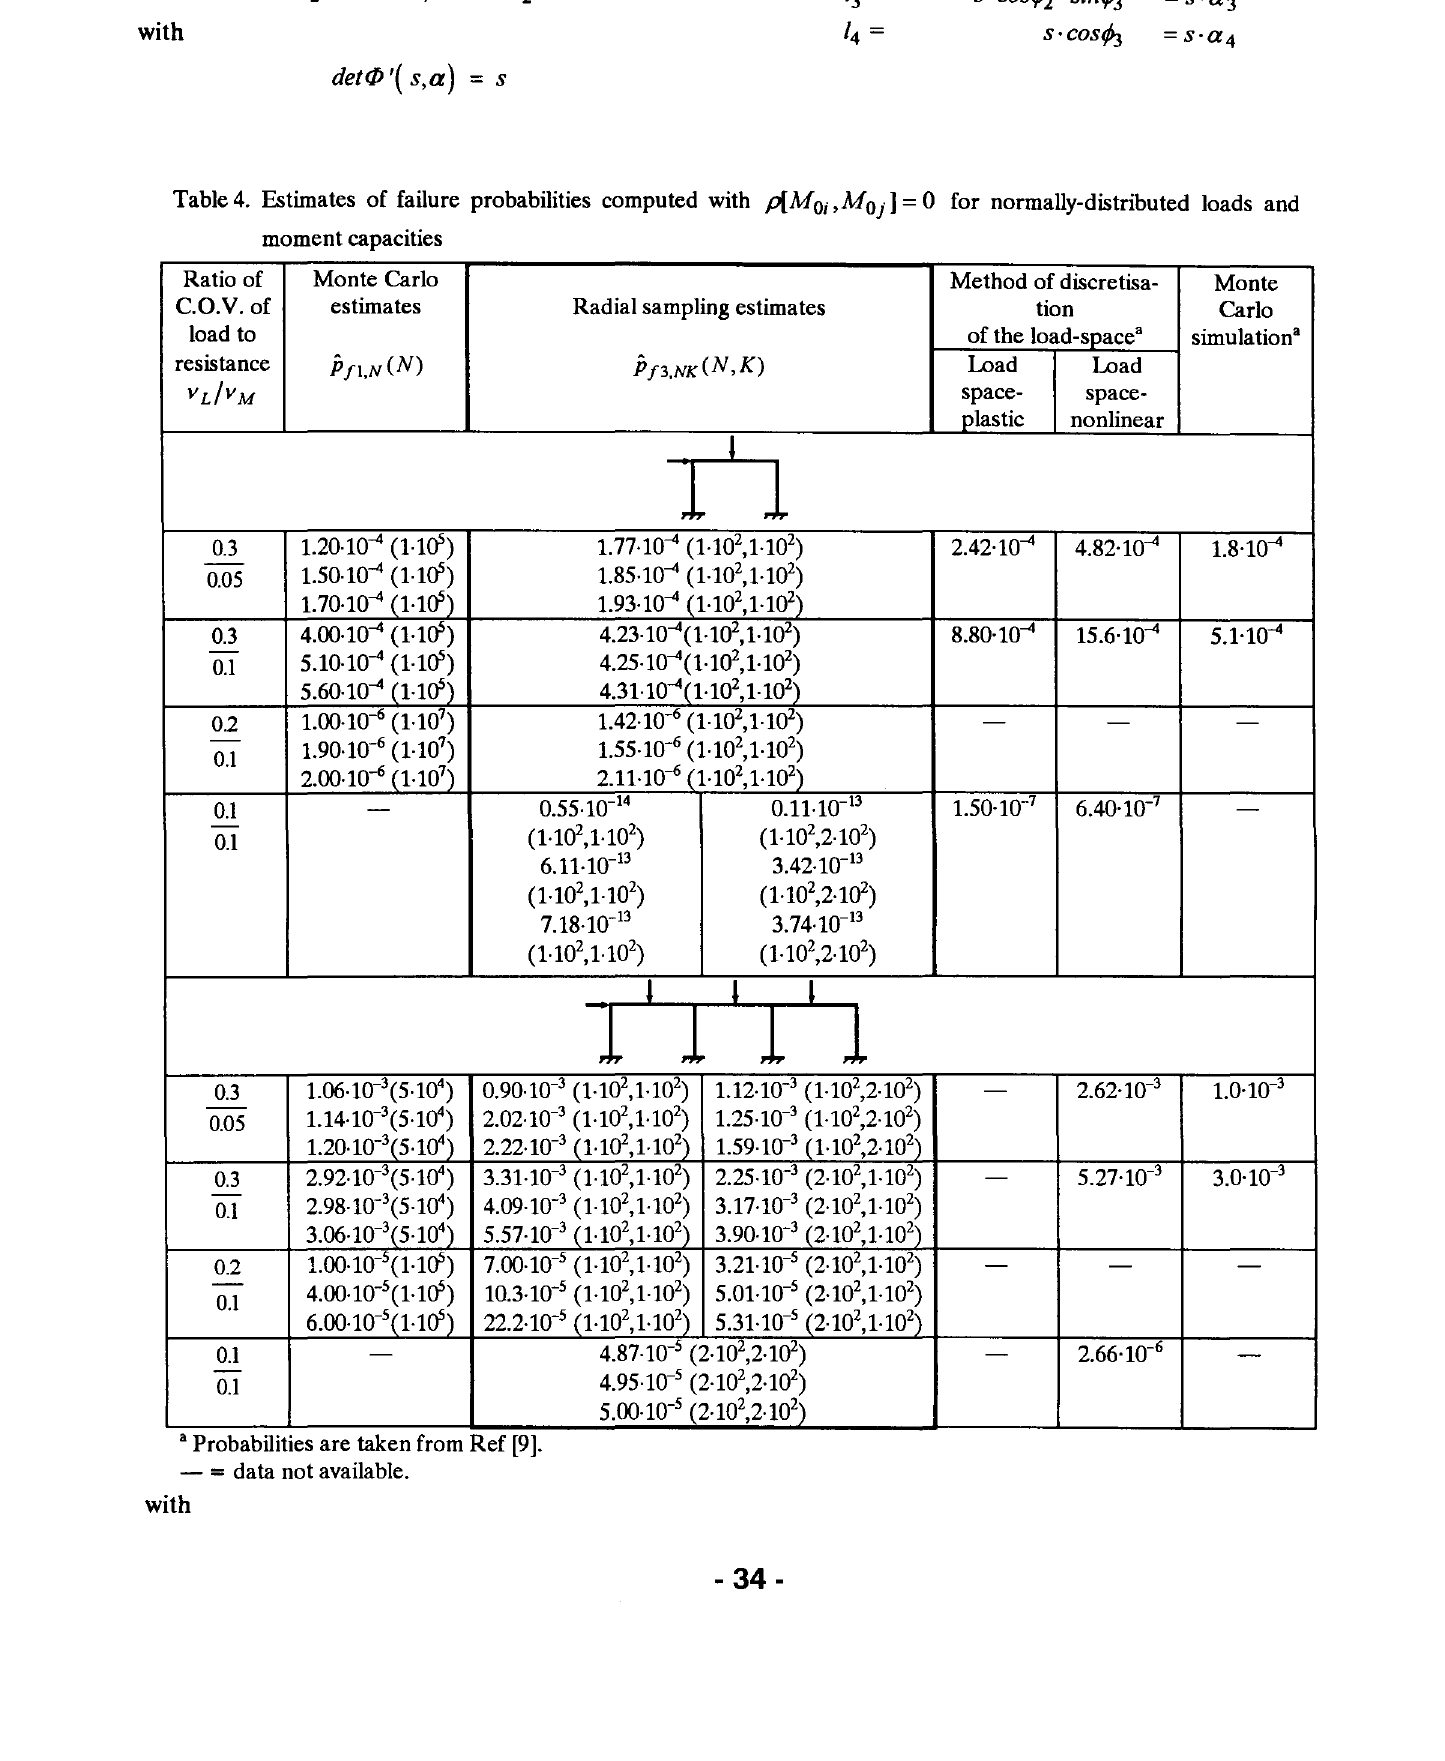
Table 4. Estimates of failure probabilities computed with p[M 0; ,M